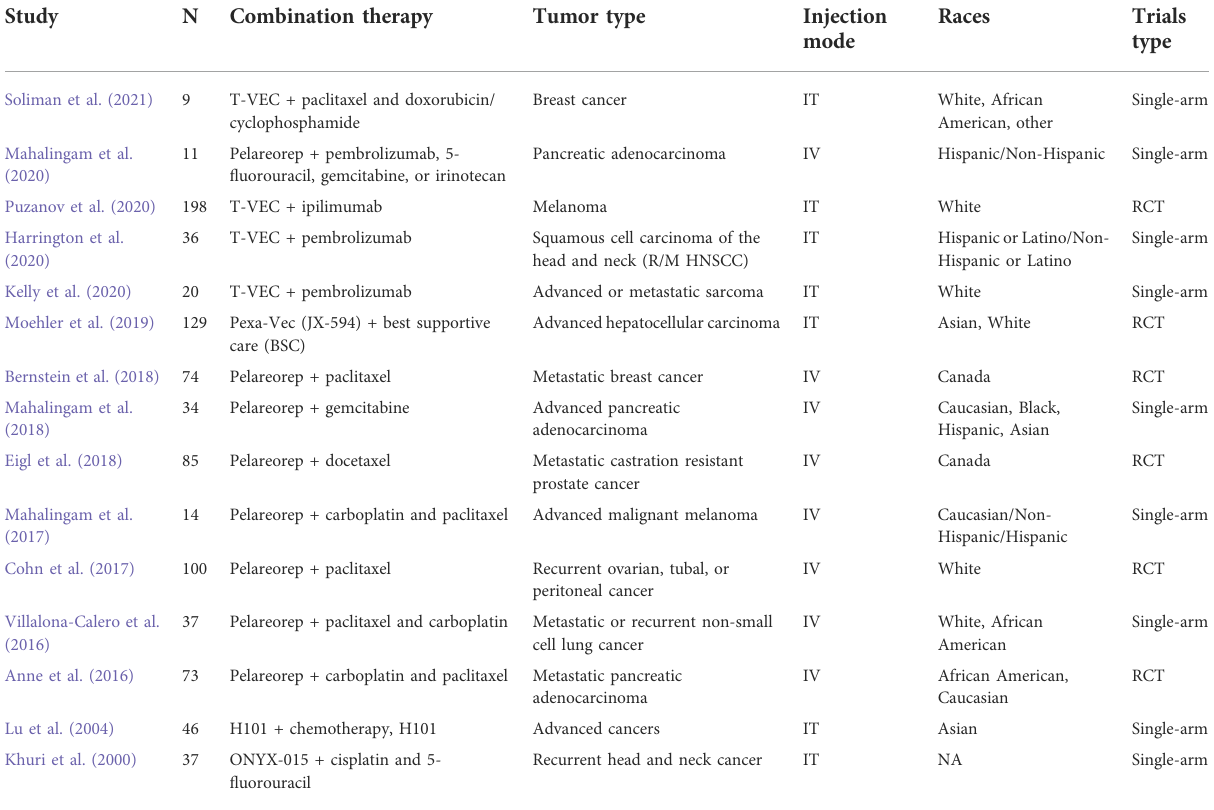
TABLE 1 Main characteristics of included